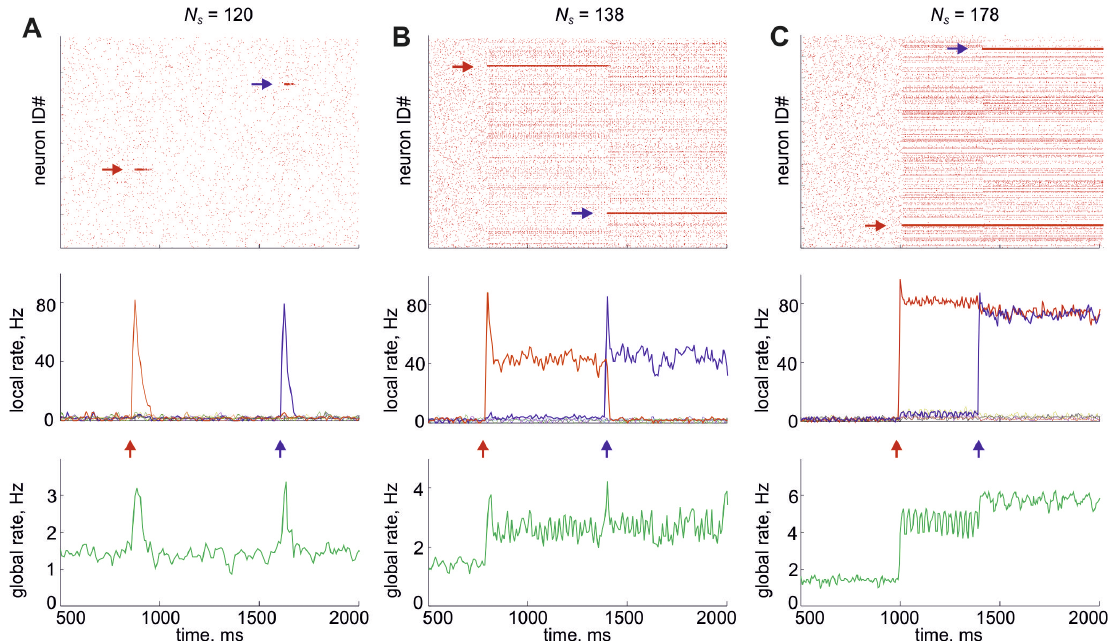
Figure 5. Implications of the local clustering on the large-scale dynamics. A–C, The spike rastergrams of all 10000 excitatory neurons (top), the averaged firing rate of the local subnetworks (middle) and the averaged firing rate of the entire network (bottom) are shown for different values of the size of each subnetwork: N s =120 (A), 138 (B) and 178 (C). In the middle panels the firing rates of different subnetworks are shown by different colors. Arrows in top and middle panels indicate the clusters of neurons activated by brief external stimuli and the stimulus timing, respectively. In (B) and (C), some neurons outside the active clusters also exhibit slightly higher firing rates if they are projected to by sparse strong synapses from these clusters.